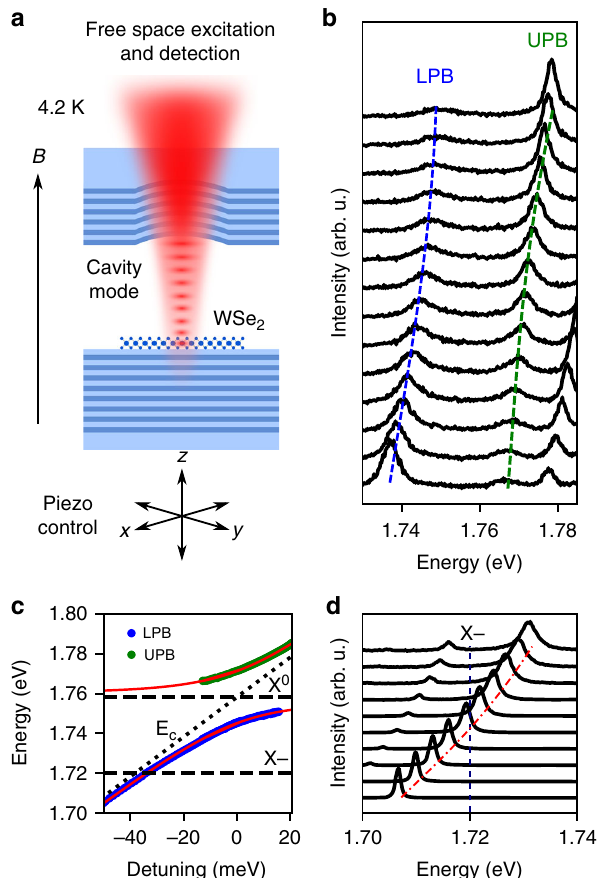
Fig. 2 Strong exciton-photon coupling in WSe 2 monolayers. a Schematic of a WSe 2 monolayer placed in an open hemispherical 0-dimensional microcavity, maintained at 4.2 K in a LHe bath cryostat with superconducting magnet. Piezo nanopositioners allow tuning of cavity length. b Photoluminescence spectra measured as the cavity mode is scanned across the exciton resonance, showing the formation of the lower and upper polariton branches, LPB and UPB, respectively. Blue (green) dashed curves guide the approximate peak positions of the LPB (UPB). c Extracted polariton peak positions as a function of the exciton-photon detuning. E c (dotted line) is the energy of the tunable cavity mode. Dashed lines are the energies of the exciton and trion. The green (blue) symbols show spectral positions of the UPB (LPB) peaks. The red lines correspond to a coupled oscillator model fi t with a Rabi splitting of 26.2 ± 0.1 meV. d Spectra corresponding to tuning the ground state mode through the trion energy, demonstrating weak coupling between the cavity and trion. Blue (red) dashed line indicates the energy of the trion (cavity